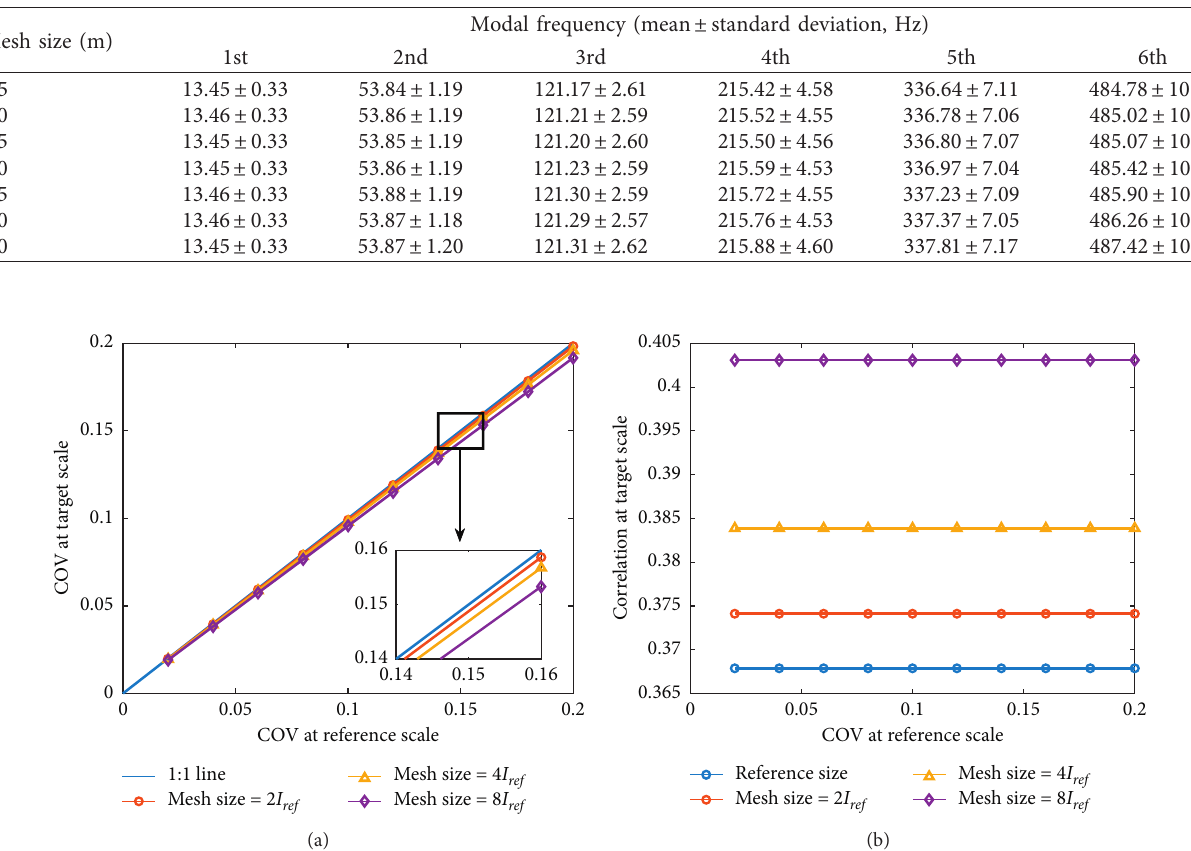
Figure 10: The cumulative distribution of modal frequencies based on the 10,000 MCSs: (a) first-order modal frequency and (b) sixth-order modal frequency. Table 2: Modal frequencies based on the meshes with different sizes.